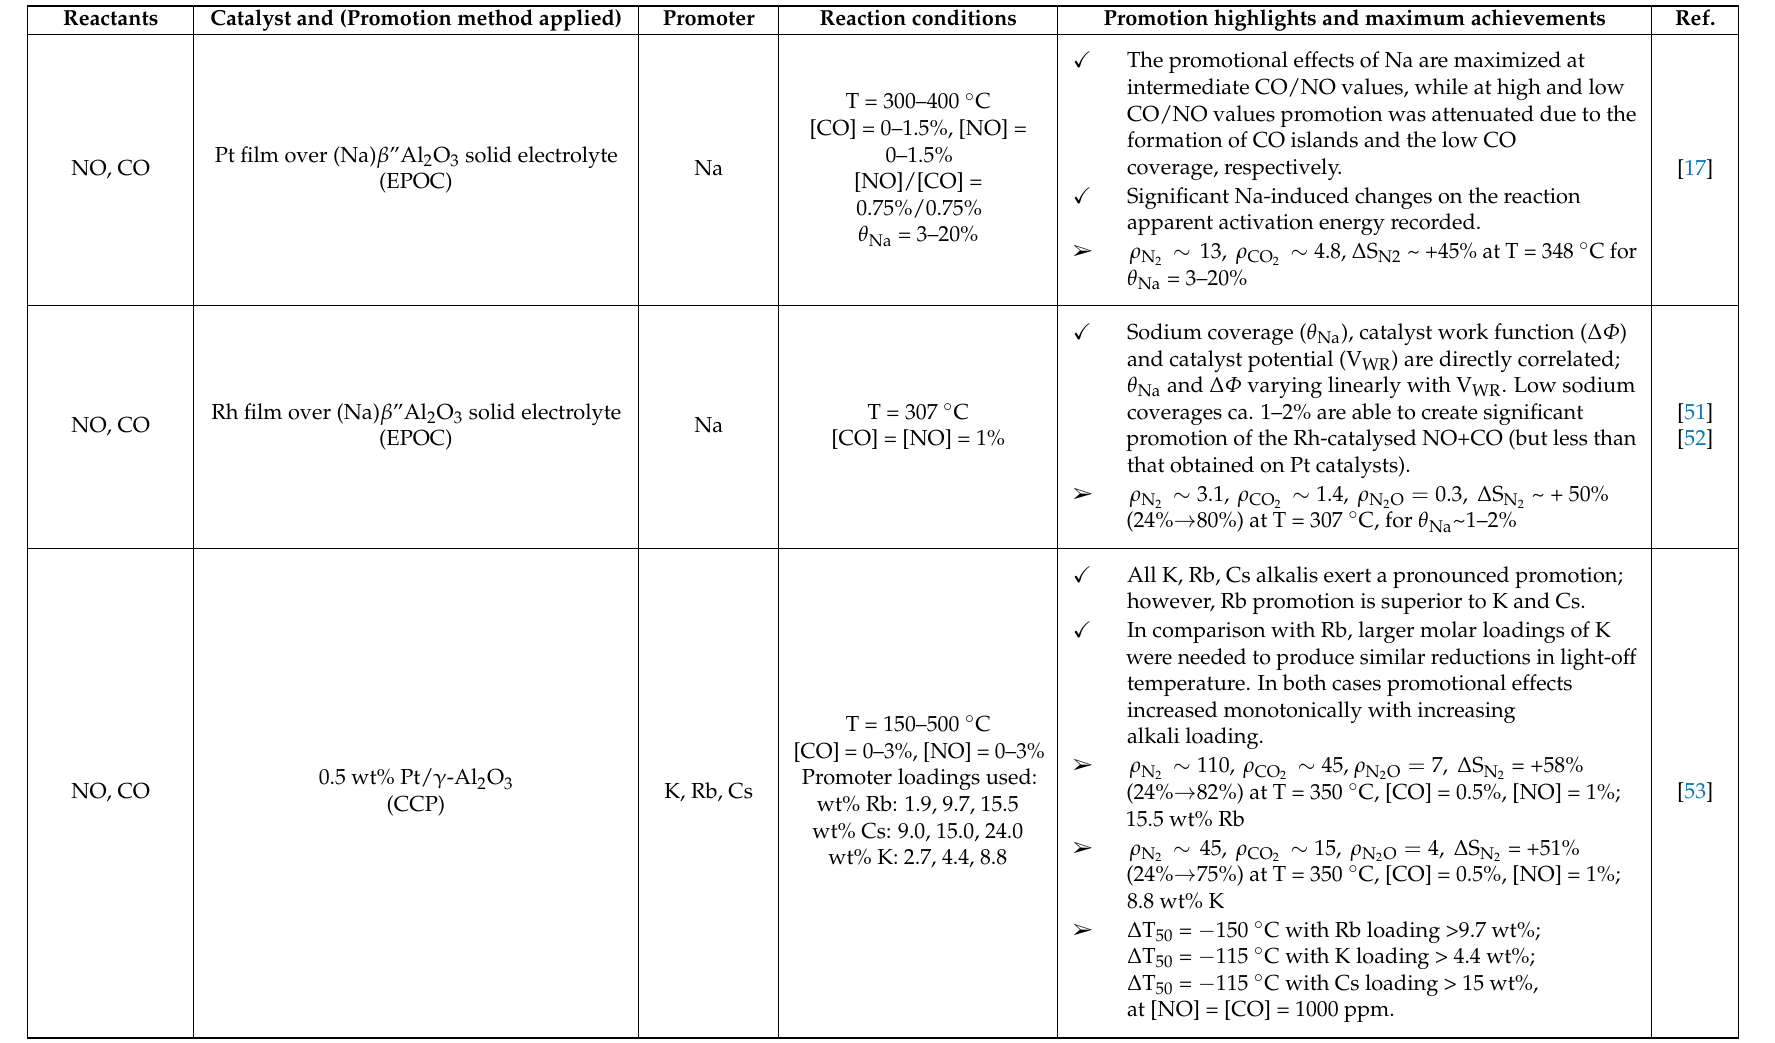
Table 3. Electropositive promotion of PGMs-catalysed NO reduction by CO (NO + CO).